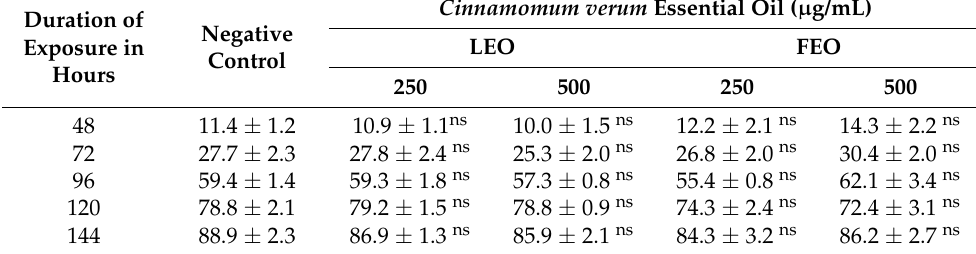
Table 4. The toxicity analysis of flower (FEO) and leaf (LEO) essential oil of Cinnamomum verum in the germinating wheat grains (estimated as germination index) (ns- indicate no significant variation with the negative